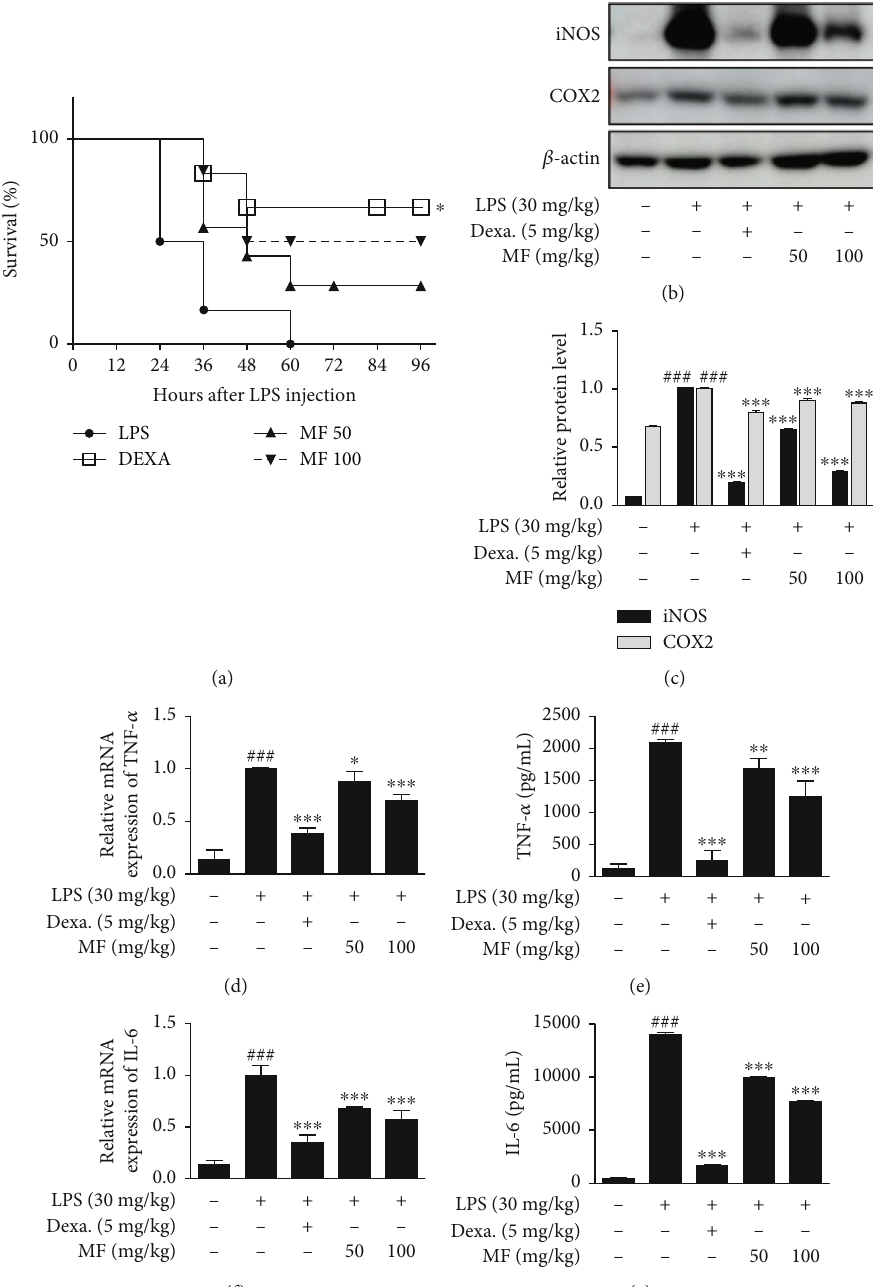
Figure 1: E ff ect of MF on proin fl ammatory enzymes and cytokine production in LPS-challenged mice. Mice were intraperitoneally injected with either Dexa, MF, or PBS (as a vehicle) for 1h before intraperitoneal LPS injection (30 mg/kg) (6 mice per group). (a) Survival rates of these mice were determined 96h postinjection. (b and c) Liver tissue samples were obtained 4h post-intraperitoneal LPS injection. Expression of COX-2 and iNOS was determined by western blot with speci fi c antibodies. Densitometric analysis was performed using ImageJ software. β -Actin was used as an internal control. (d and f) Total RNA was isolated from the liver tissue samples, and then, mRNA expression of TNF- α (d) and IL-6 (f) was determined with qRT-PCR. (e and g) Peripheral blood samples were obtained from each mouse. Serum levels of TNF- α (e) and IL-6 (g) were determined using EIA kits. The data are presented as the mean ± SD . ### p < 0 : 001 vs. the control group; ∗ p < 0 : 05 , ∗∗ p < 0 : 01 , and ∗∗∗ p < 0 : 001 vs. the LPS-only-challenged